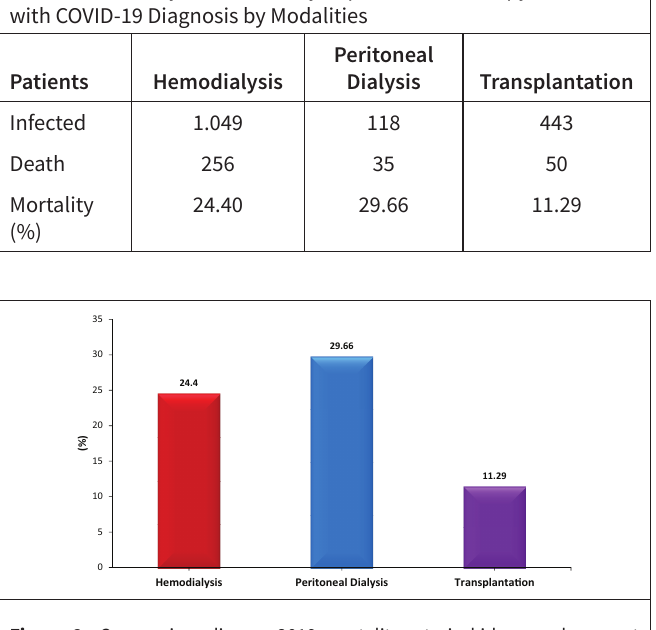
Figure 2. Coronavirus disease 2019 mortality rate in kidney replacement therapy modalities.